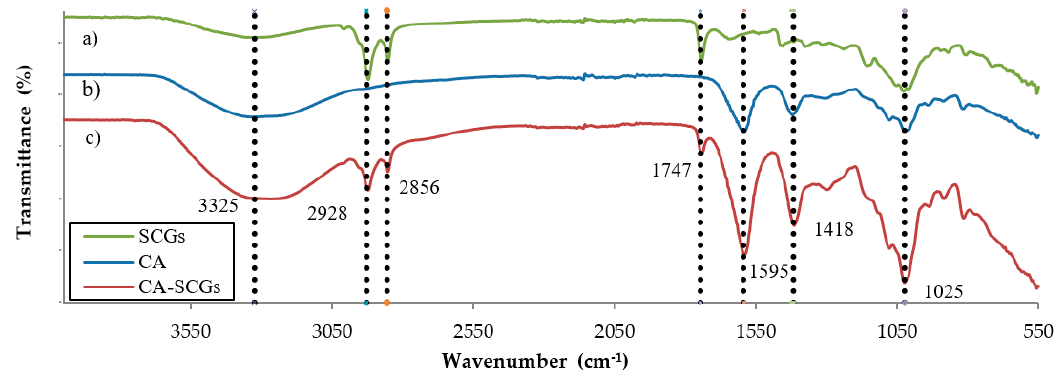
Figure 4. Comparison of the FT–IR spectra of ( a ) SCGs, ( b ) CA beads and ( c ) CA–SCGs beads.